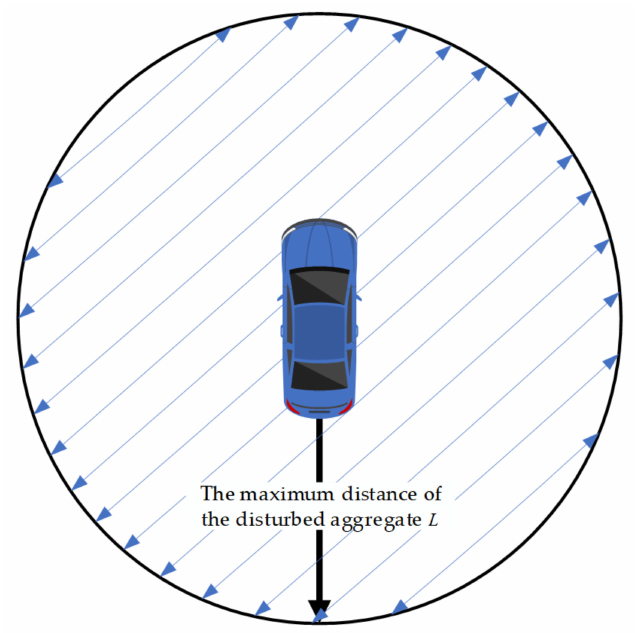
Figure 6. Disturbance characteristics of